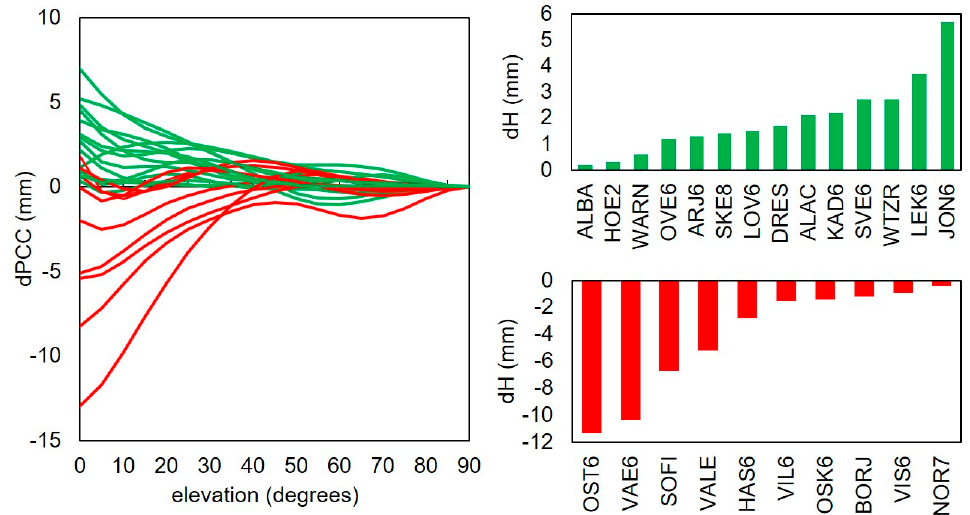
Figure 5. Comparison of the difference in PCC (dPCC; left) and mean differences between solution sol_i_0 and sol_t_0 (right). Stations with positive bias are shown in green, while those with negative bias are shown in red.